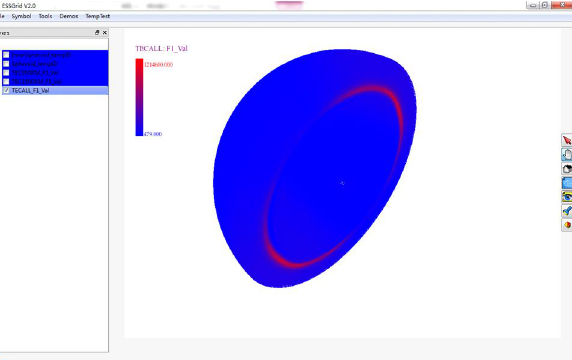
Figure 8. 3D distribution of ionosphere in all layers using